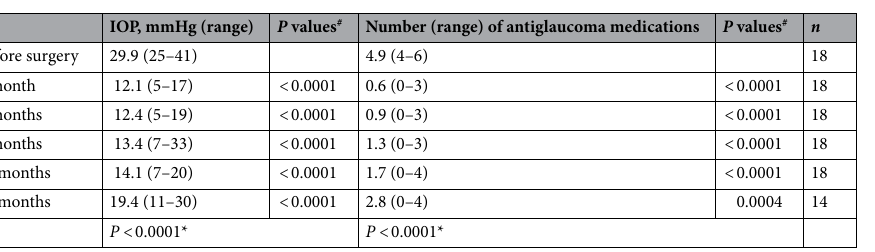
Table 2. Intraocular pressure and number of antiglaucoma medications used in patients. IOP intraocular pressure. #Calculated using the t test between the preoperative and respective time period values. *Calculated using the mixed-effects regression